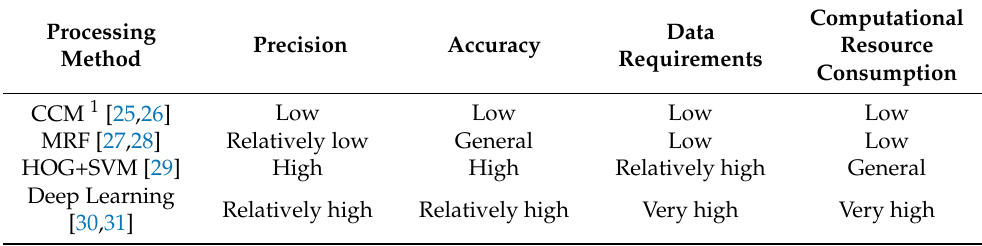
Table 1. Comparison of performance characteristics of several image-processing methods to detect a